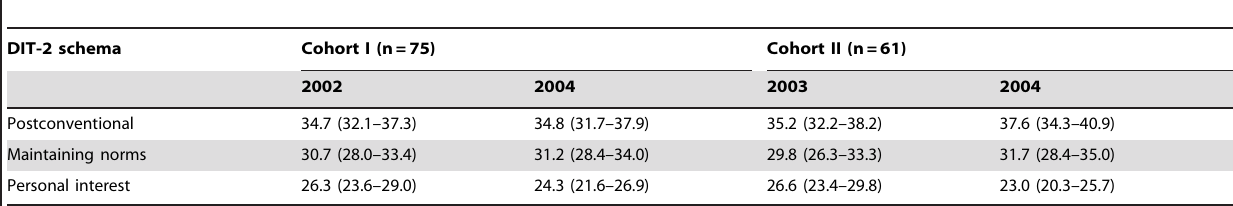
Table 2. Average values (95% confidence intervals) of DIT-2 scores* in repeated measurements on 2 cohorts of medical students { .